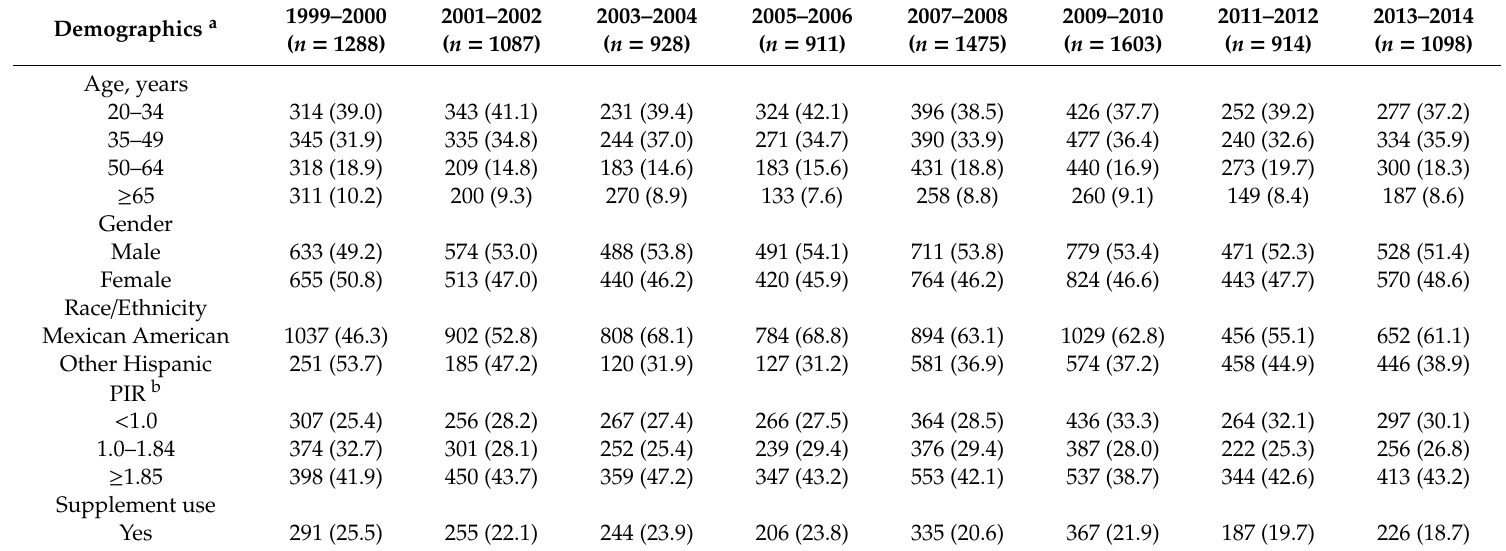
Table 1. Demographics of Hispanic adults aged ≥ 20 years by National Health and Nutrition Examination Survey (NHANES) cycle, 1999–2014 ( n =